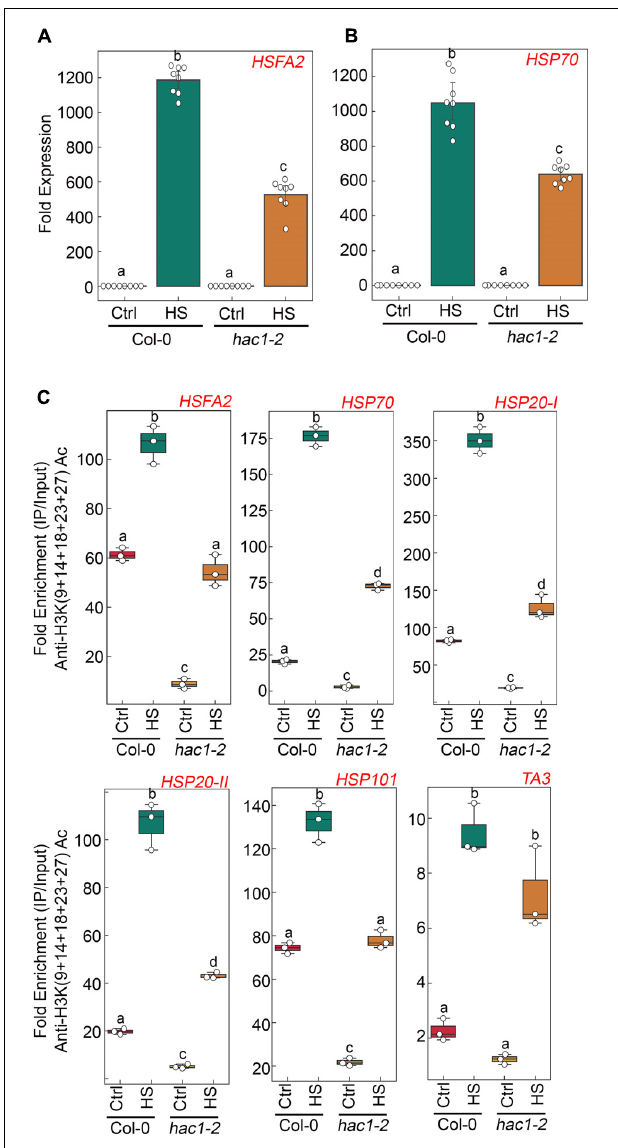
FIGURE 7 | hac1 mutant demonstrates less accumulation of H3K acetylation, leading to perturbation in HS-induced gene expression. (A,B) RT-qPCR expression of HS genes in Col-0 and hac1 mutants in response to HS. Seven-day-old 0.5X MS-grown Col-0 and hac1-2 seedlings were subjected to 3 h of HS treatment at 37 ◦ C. RT-qPCR analysis was performed on two independent biological replicates, each containing three technical replicates ( n = 2). Different letters denote statistical differences at p < 0.05 as assessed by one-way ANOVA and Tukey’s HSD post hoc test. (C) ChIP-qPCR showing enrichment of histone H3K Ac (9 + 14 + 18 + 23 + 27) at the promoters of HS gene-encompassing HSEs in Col-0 and hac1-2 . The amount of immuno-precipitated promoter DNA was calculated by comparing samples treated without or with an anti-Histone H3K (9 + 14 + 18 + 23 + 27) acetyl antibody. Ct values without and with antibody samples were normalized by input control. (C) Seven-day-old 0.5X MS-grown Col-0 and hac1-2 seedlings were subjected to 3 h of HS treatment at 37 ◦ C. ChIP-qPCR analysis was performed on three technical replicates ( n = 3) from a single representative experiment. The experiment was independently repeated two times (biological replicates; n = 2). Different letters denote statistical differences at p < 0.05 as assessed by one-way ANOVA and Tukey’s HSD post hoc